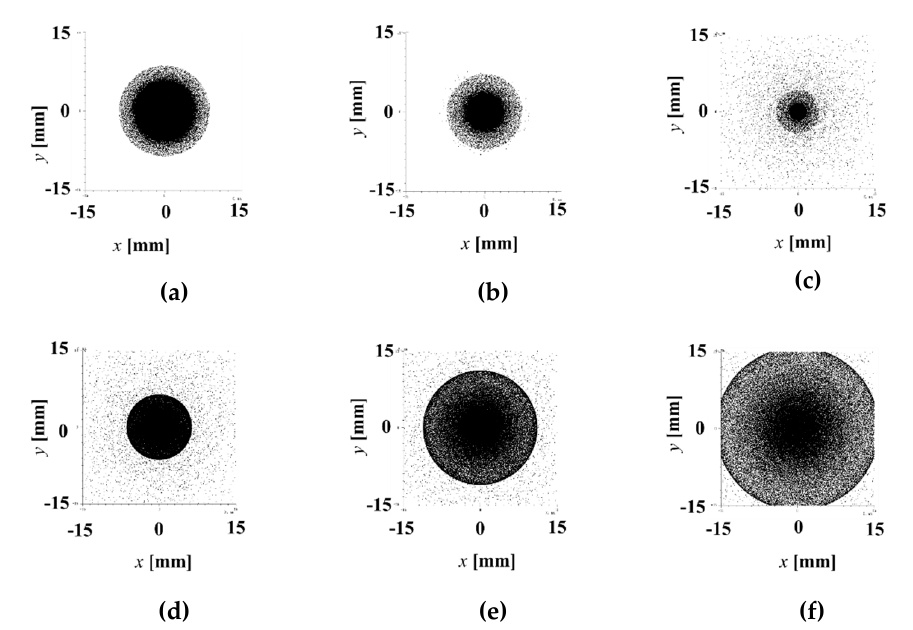
Figure 7. Simulated ray distribution of the CSSP lens at the focal plane length f : f = ( a ) 15 mm, ( b ) 18 mm, ( c ) 24 mm, ( d ) 30 mm, ( e ) 36 mm, and ( f ) 42 mm.